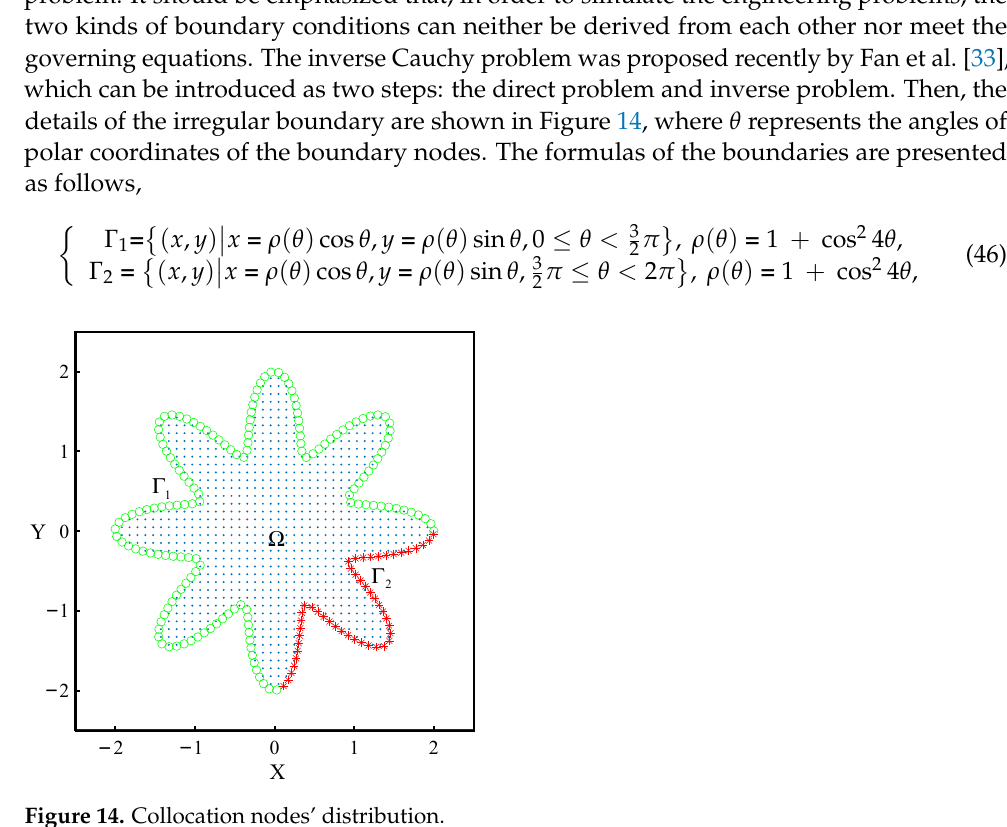
Figure 14. Collocation nodes’ distribution.